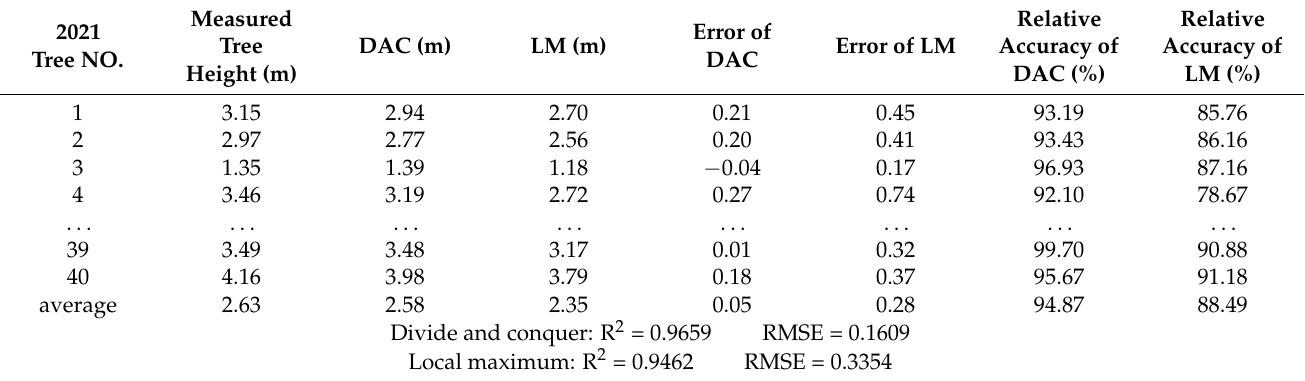
Table 3. Accuracy verification of tree heights in 2021 from DAC and